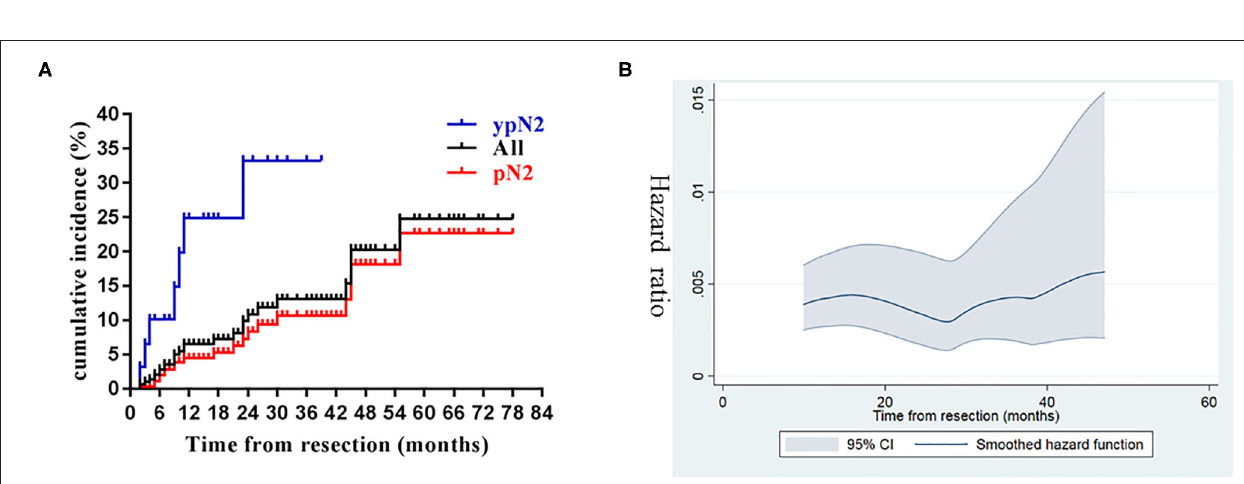
The positive rate of HER2, TTF1, ERCC1, CK20, CK5/6,